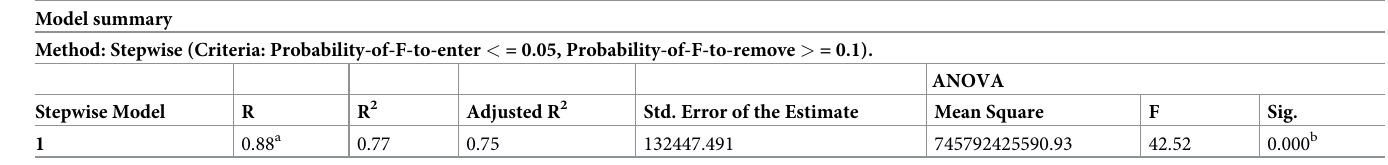
Table 5. Stepwise regression for the relationships between female enrollment, socio-economic factors (general government expenditure, unemployment rate, per capital income, GDP per capita (PPP constant 2011 international $), and GDP at market price) of Pakistan during 2001–02 to 2015–16. Model summary